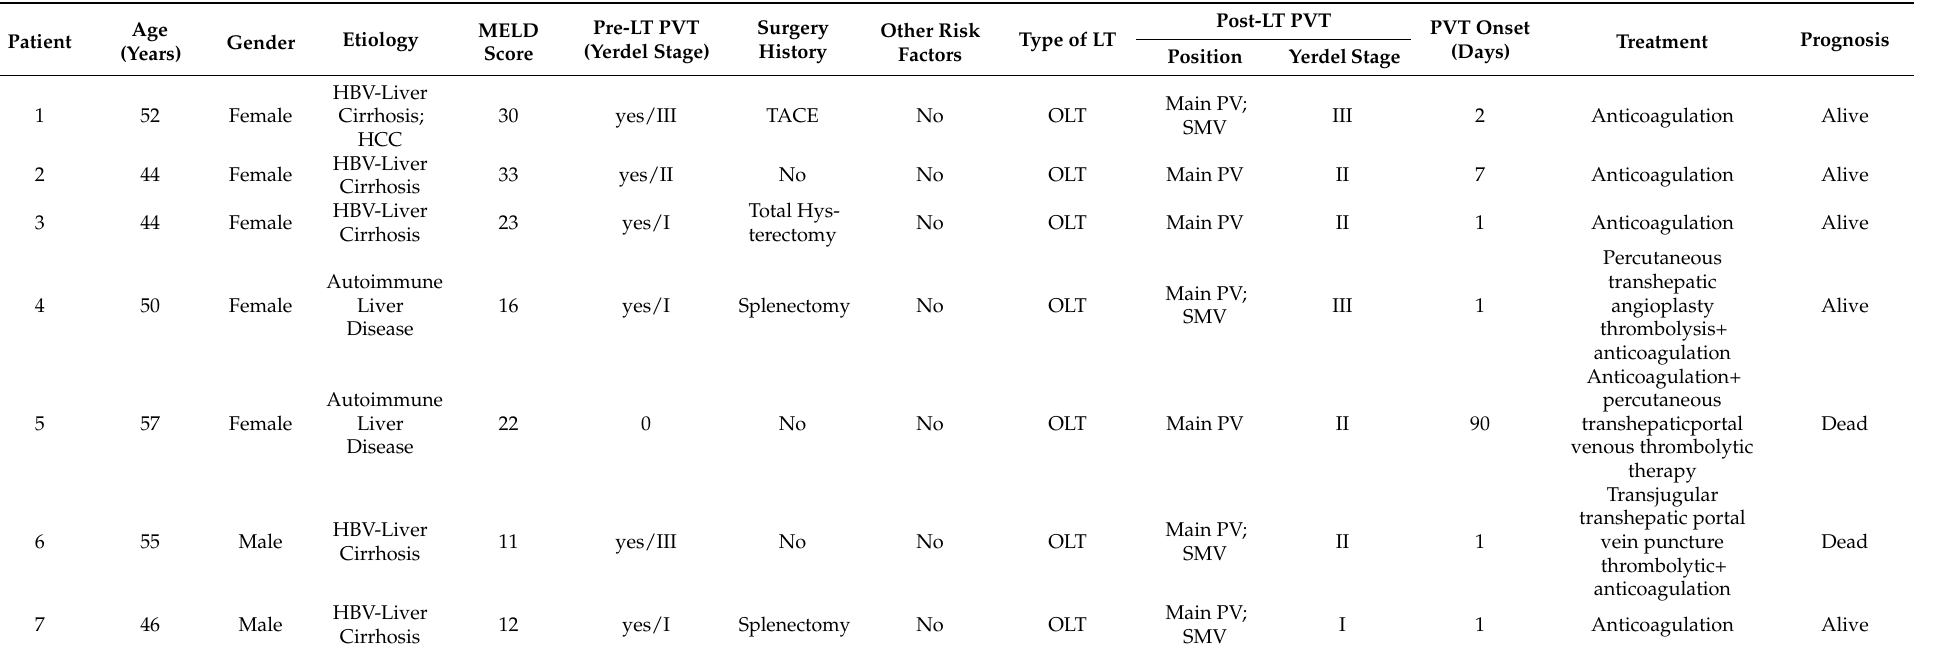
Table 1. Characteristics of patients with PVT after orthotopic liver